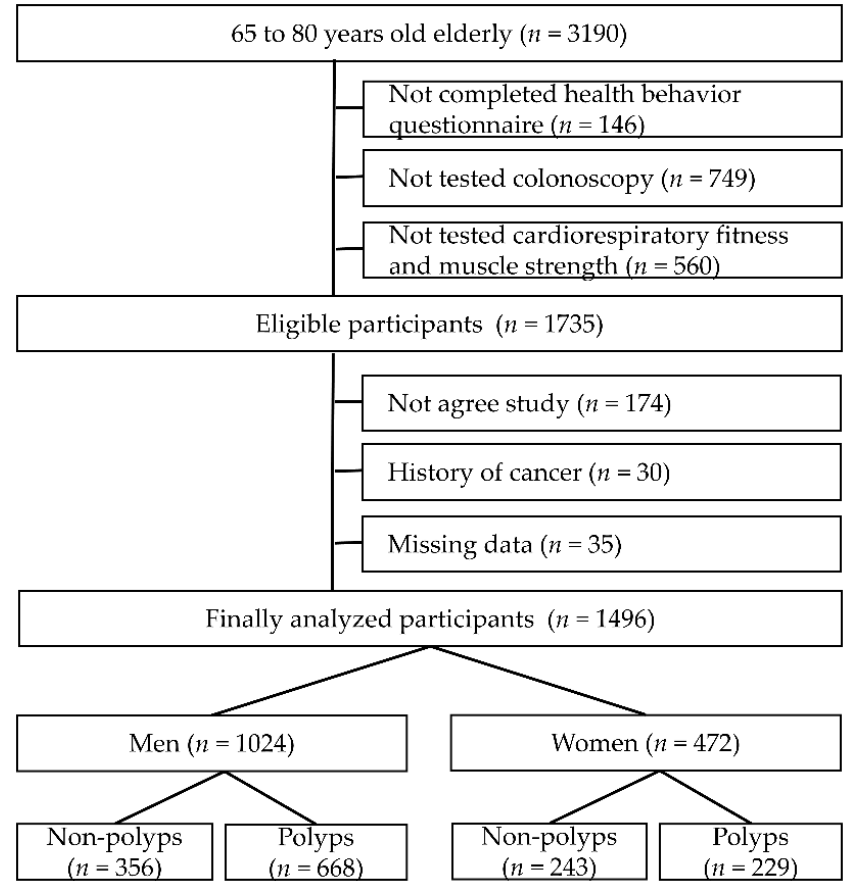
Figure 1. Diagram of participant inclusion and exclusion.